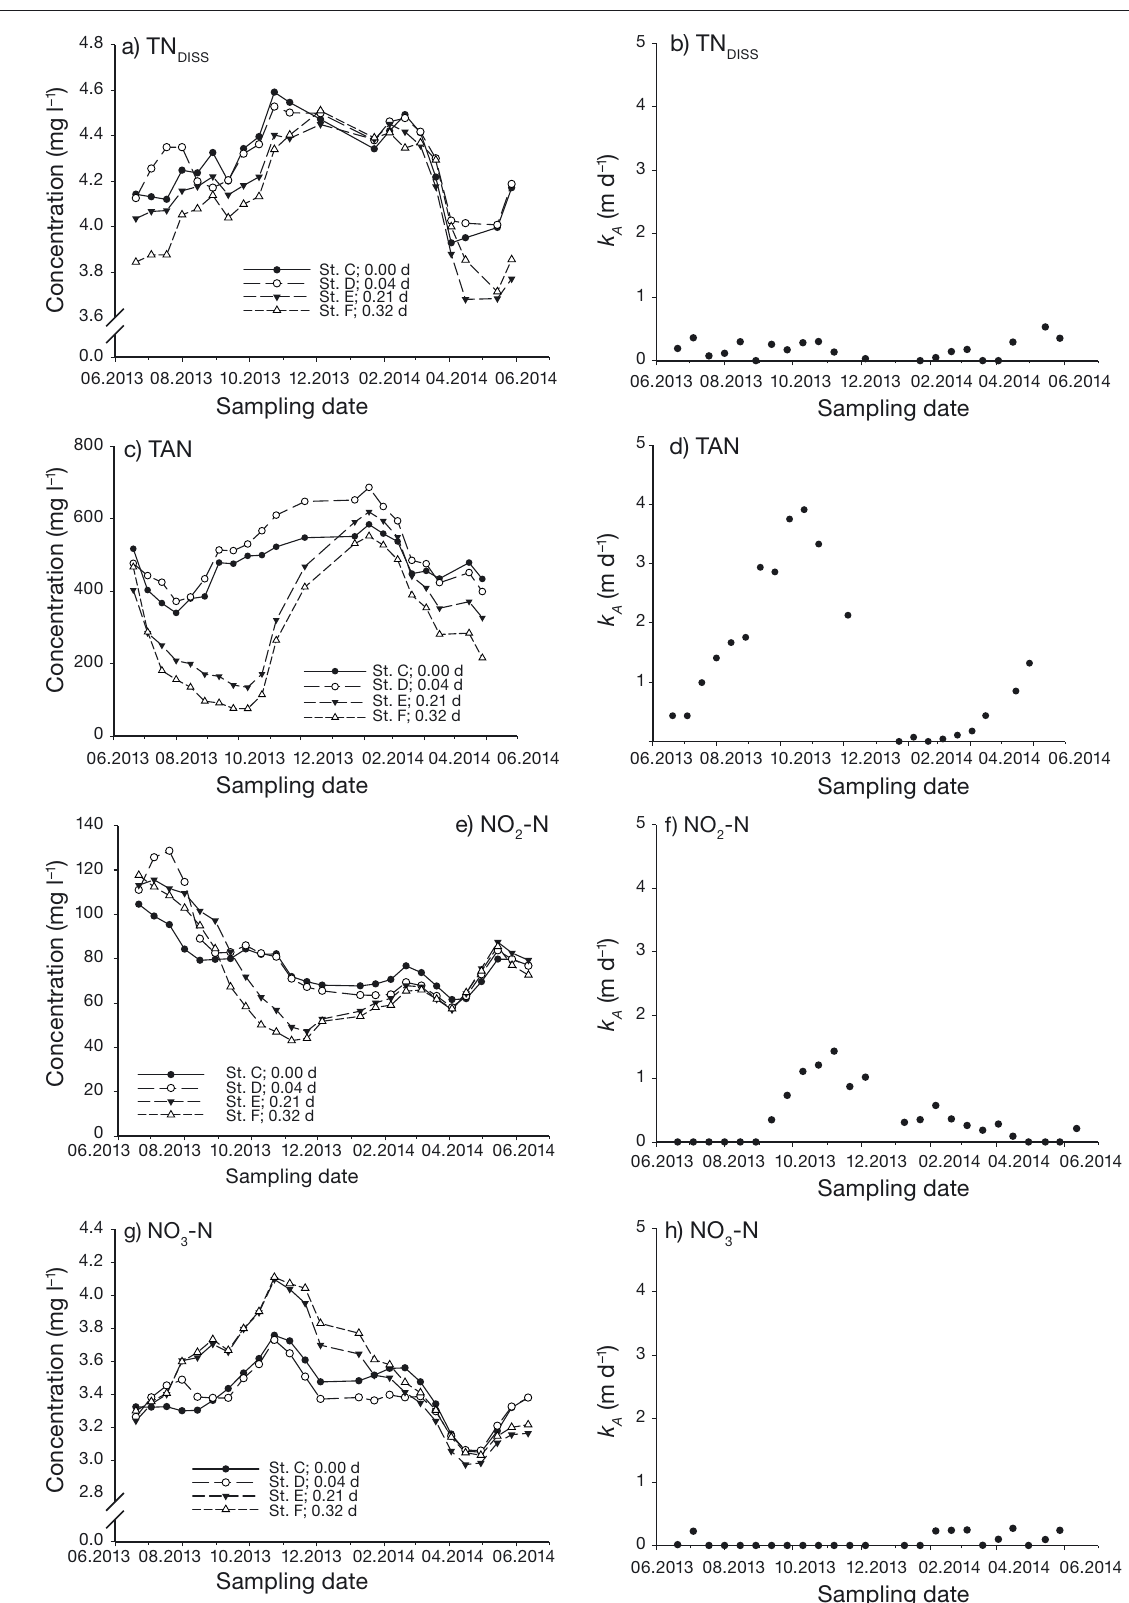
Fig. 6. Concentrations (a,c,e,g; running averages of 3 concurrent sampling events) of total dissolved nitrogen (TN DISS ) and its main constituents (TAN, NO 2 -N, NO 3 -N) measured at increasing hydraulic retention time (HRT; in d) relative to the wetland inlet sta- tion (Stn C, cf. Fig. 1) during the year of bi-weekly sampling. Also shown are the corresponding area-based reaction coefficients ( k A ; in m d −1 ; b,d,f,h). Background concentrations used for fitting first order kinetic plug flow models to the longitudinal transect data and deriving the